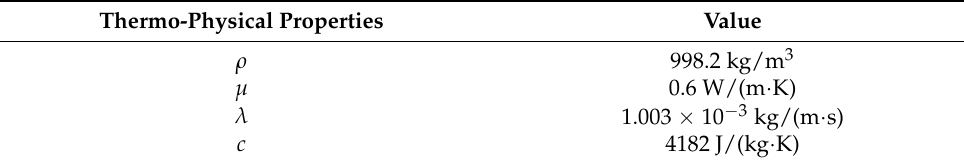
Table 2. Thermo-physical properties of